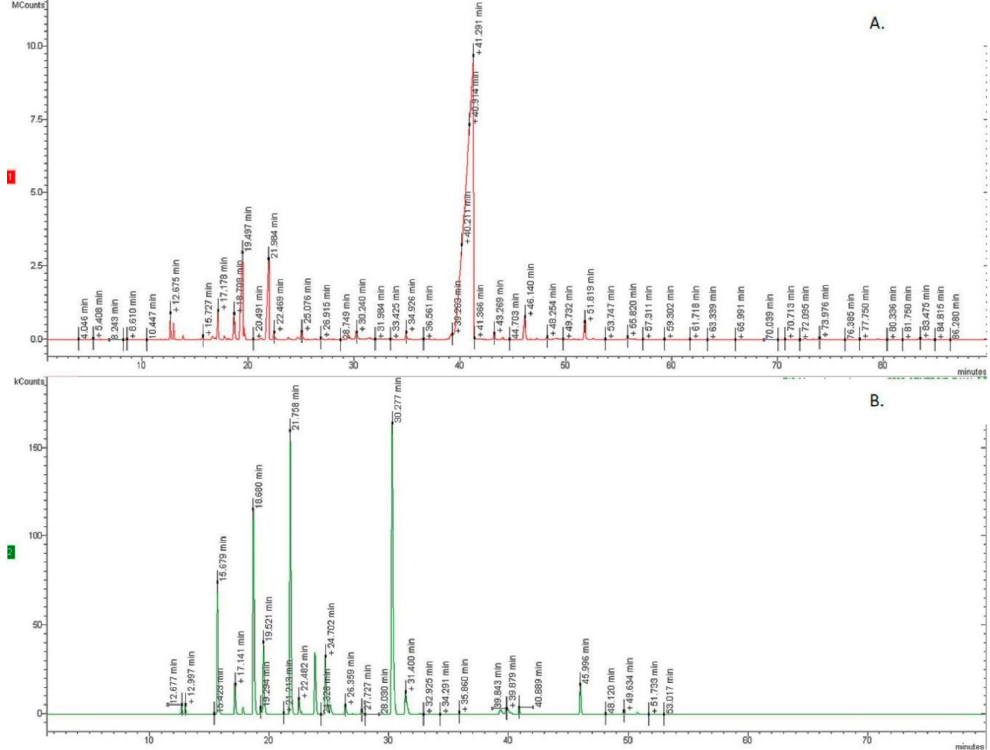
Figure 1. The Gas Chromatography (GC) profile of O. heracleoticum ( A ) and O. majorana essential oils ( B